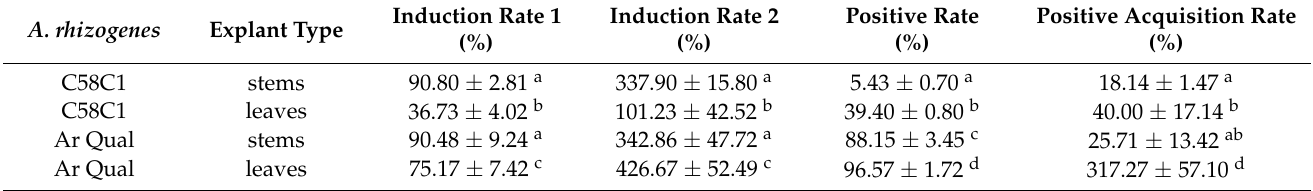
Table 1. Hairy roots induction from leaves and stems explants by A. rhizogenes C58C1 and Ar Qual.